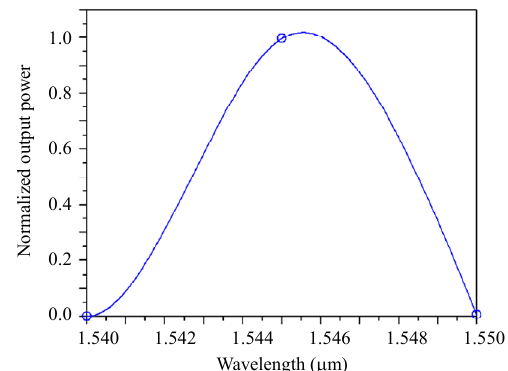
Fig. 2 Schematic structure of proposed photonic crystal based biosensor.